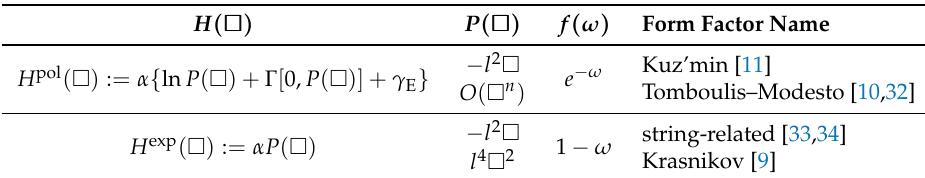
Table 1. Form factors in nonlocal